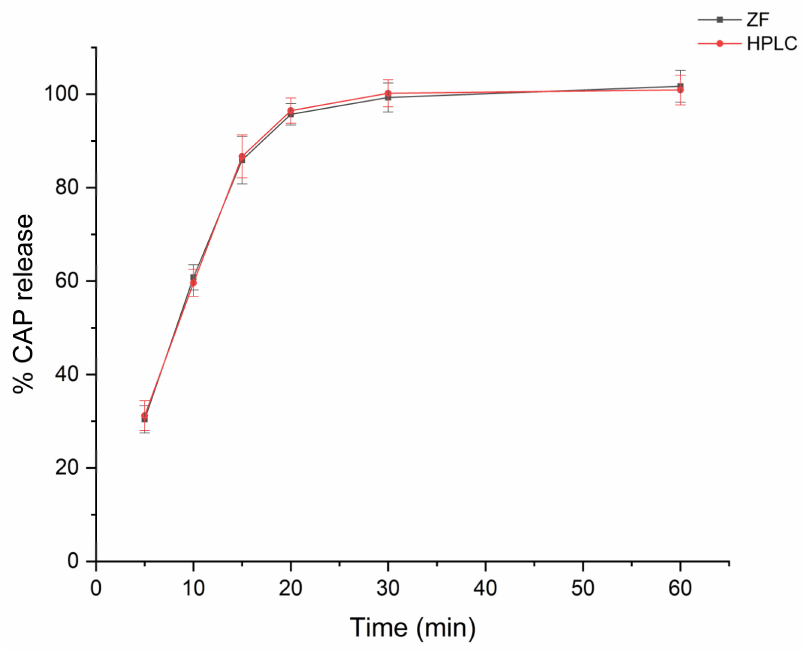
Figure 4. Comparison of the dissolution profile of captopril (Brand A) in 0.01 M HCl (T = 37.0 ± 0.5 ◦ C, V = 900 mL, rotation speed = 50 rpm, n = 12) using the proposed ZF and HPLC methods.